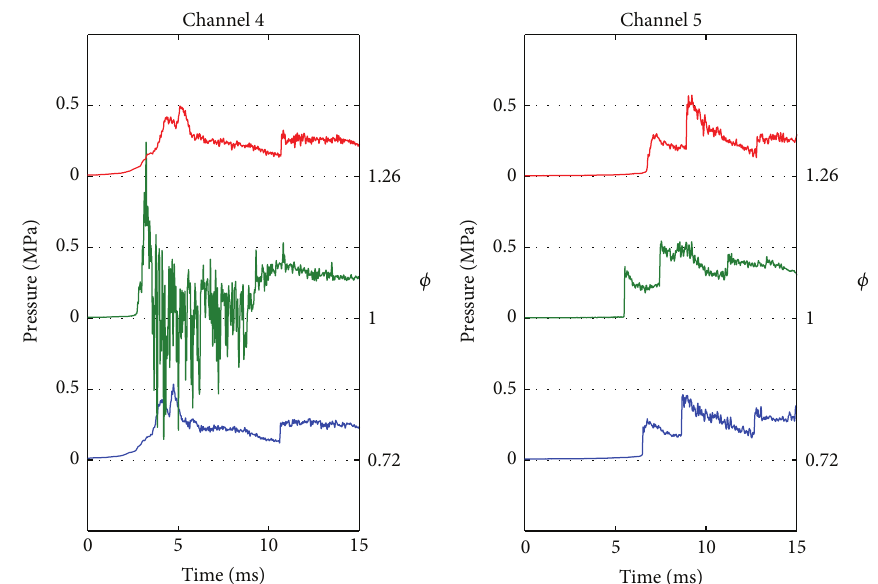
Figure 11: From bottom: tests 32, 31, and 33. Comparison of pressure records from channels 4 and 5. Lean, stoichiometric, and rich 5% H 2 S/95% NG-air mixtures. Pressure is shown on the left vertical axis, while the equivalence ratio is given on the right vertical